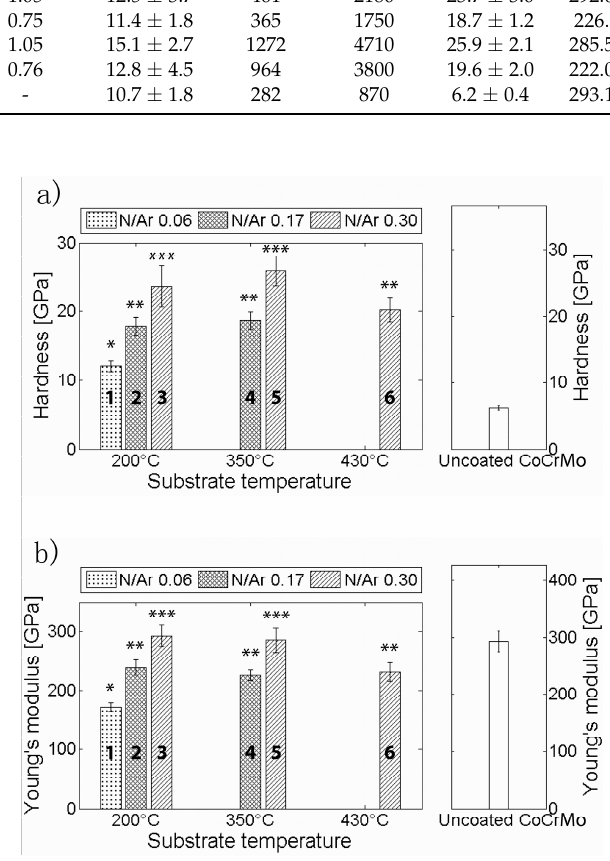
Figure 5. Nano-hardness ( a ) and Young’s modulus ( b ) values as a function of substrate temperature and nitrogen flow ratio. The process numbers are indicated in the graph. Groups that gave significantly different results have been given different letters ( * , ** and *** ).